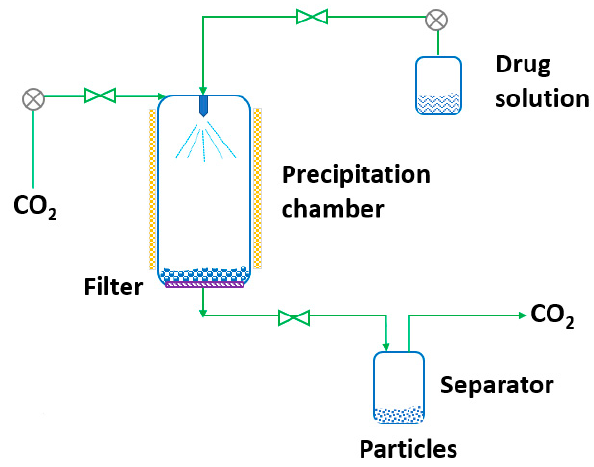
Figure 12. Supercritical Antisolvent (SAS) process (adapted from Martin and Cocero [123]).